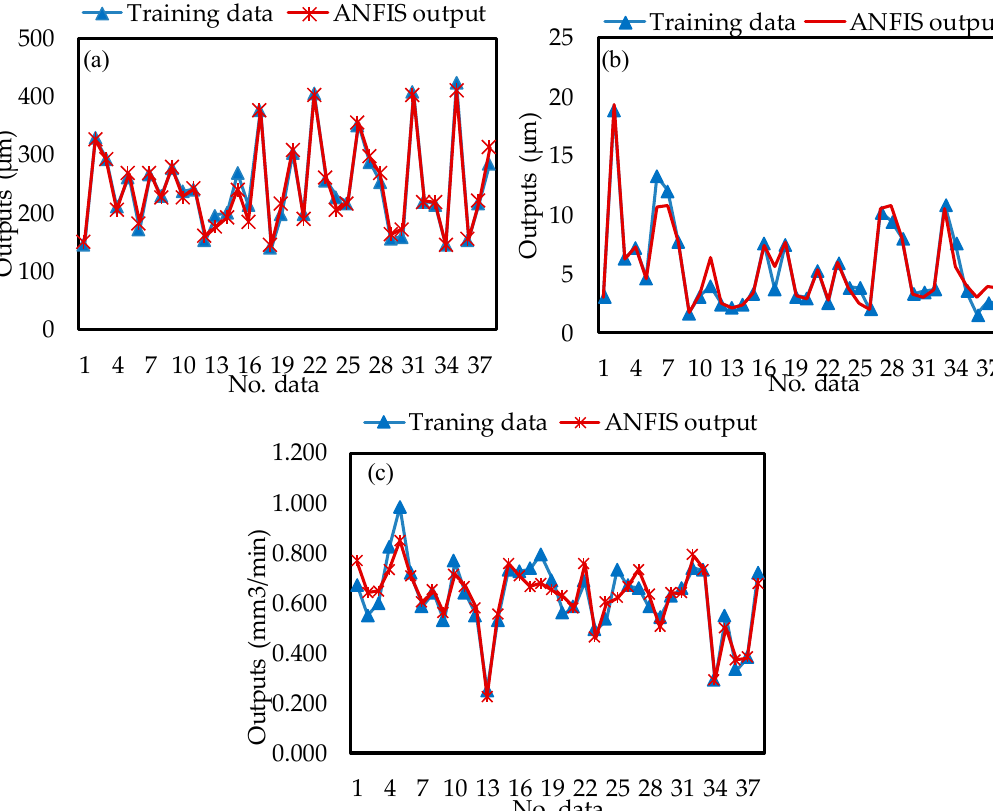
Figure 11. Comparison between the measured values and predicted ANFIS values ( a ) D; ( b ) SR; ( c ) MRR.